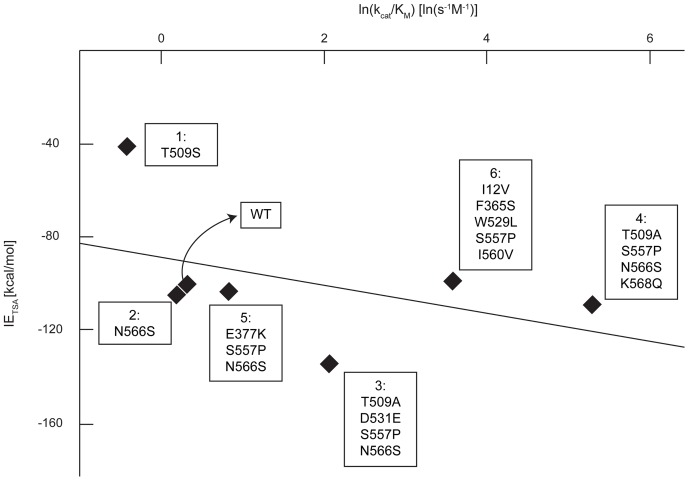
Correlation between pNP-GAL IETSA and ln(kcat/KM).The correlation found here is significantly lower than the one found for pNP-GLU (see Figure 7) primarily due to mutant T509S. See also Figure S4.